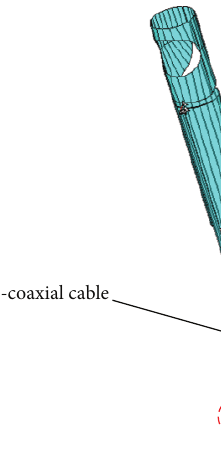
Figure 6: Antenna calculation model.